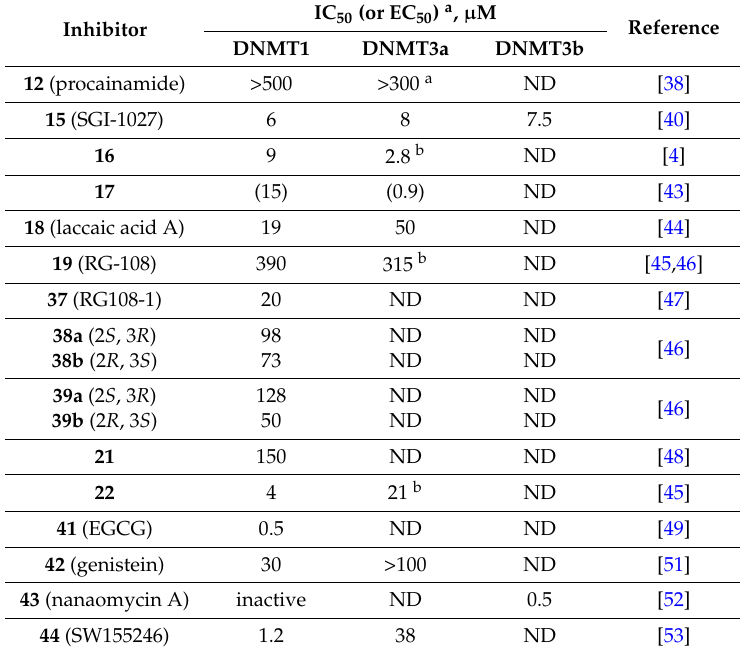
Table 1. Non-nucleoside DNA methyltransferase inhibitors (DNMTi) and their